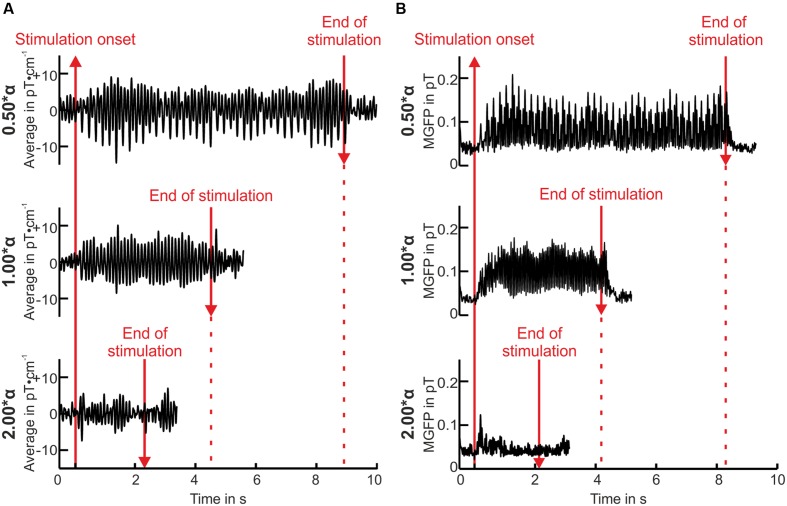
Averaged single right-occipital gradiometer channel measurement data in pT⋅cm-1 over time (A) and square root of mean global field power (MGFP) of all magnetometers (pT) over time (B) of volunteer P01. Baseline is displayed for 500 ms before and 1 s after the end of the stimulation (see red lines).